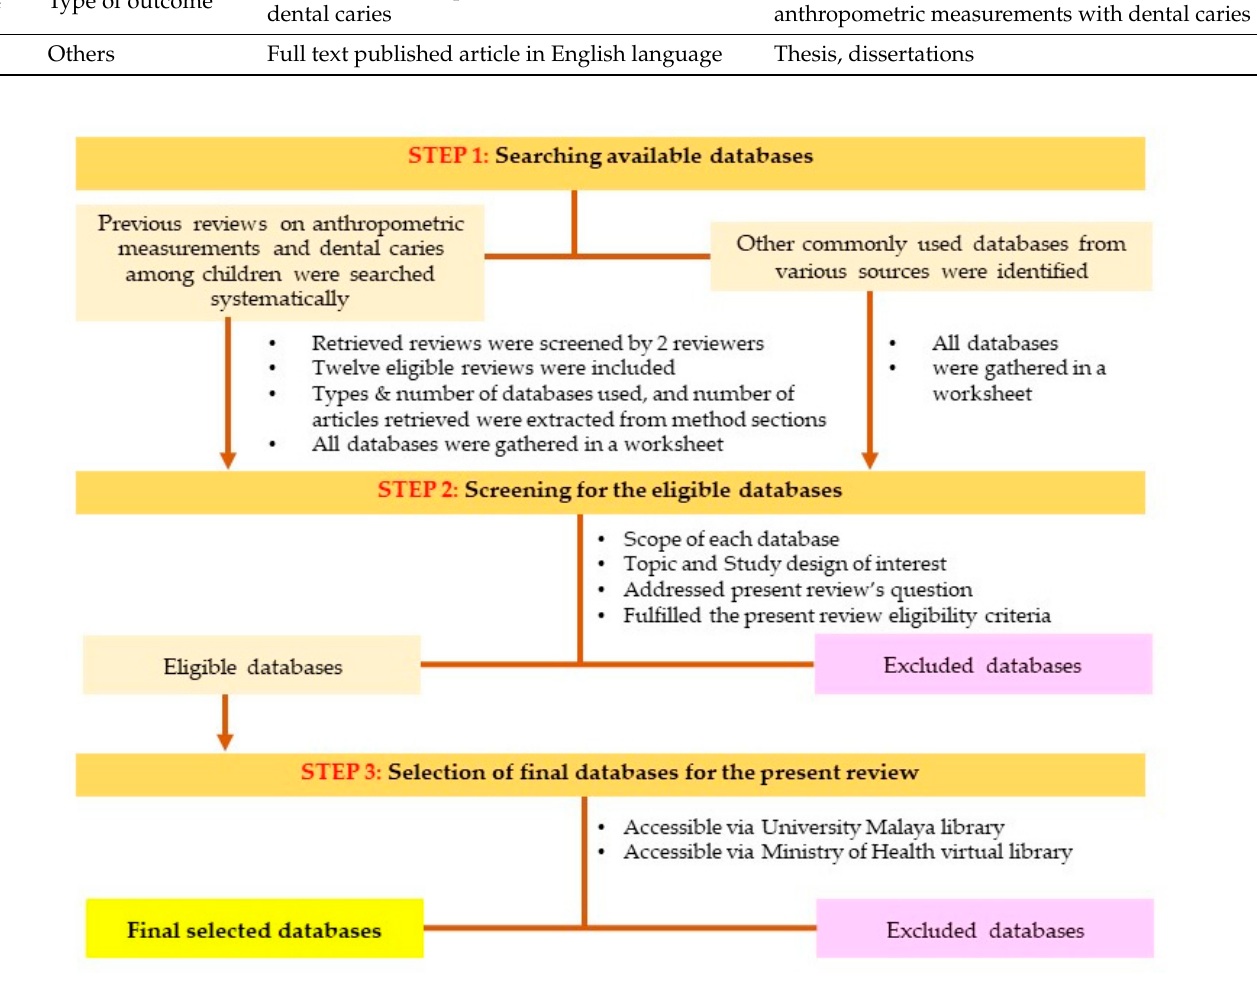
Figure 1. Flowchart for the process of databases selection for the present review.